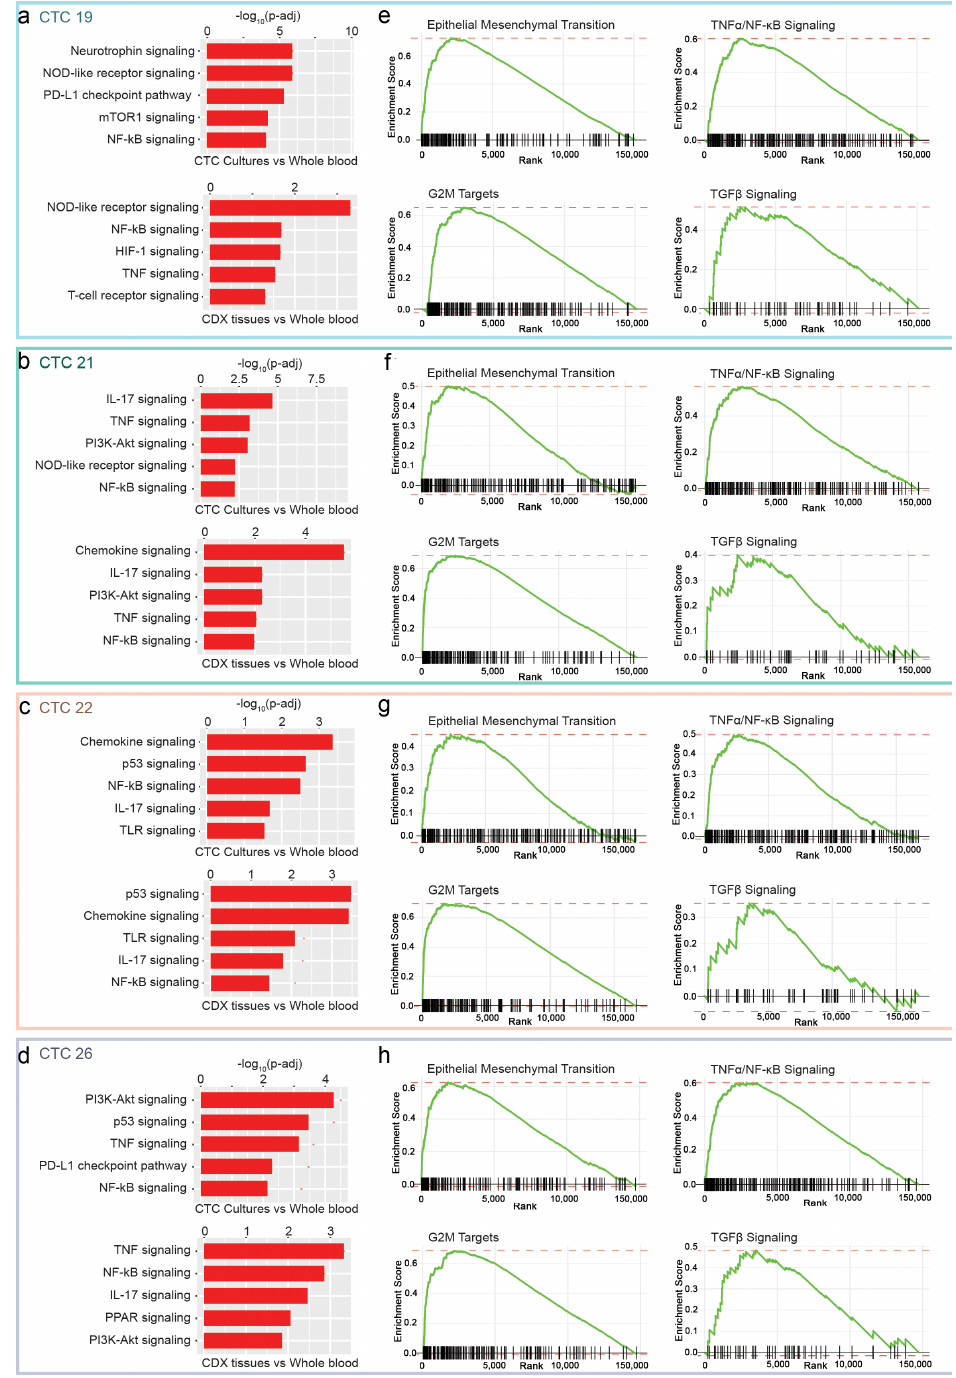
Figure 5. KEGG and GSEA pathway analysis on CTC-derived samples indicate an enrichment of EMT, TGF β , and NF- κ B signaling pathways. Waterfall plots of the top five pathways enriched via KEGG analysis in patient-specific CTC cultures or CDX tissues against whole blood samples for ( a ) patient #19, ( b ) patient #21, ( c ) patient #22, and ( d ) patient #26 are depicted. GSEA enrichment plots depicting enrichment of the hallmark gene sets EMT, TNF α /NF- κ B signaling, G2M targets, and TGF- β signaling are shown for samples from patient #19 ( e ), patient #21 ( f ), patient #22 ( g ), and patient #26 ( h ).